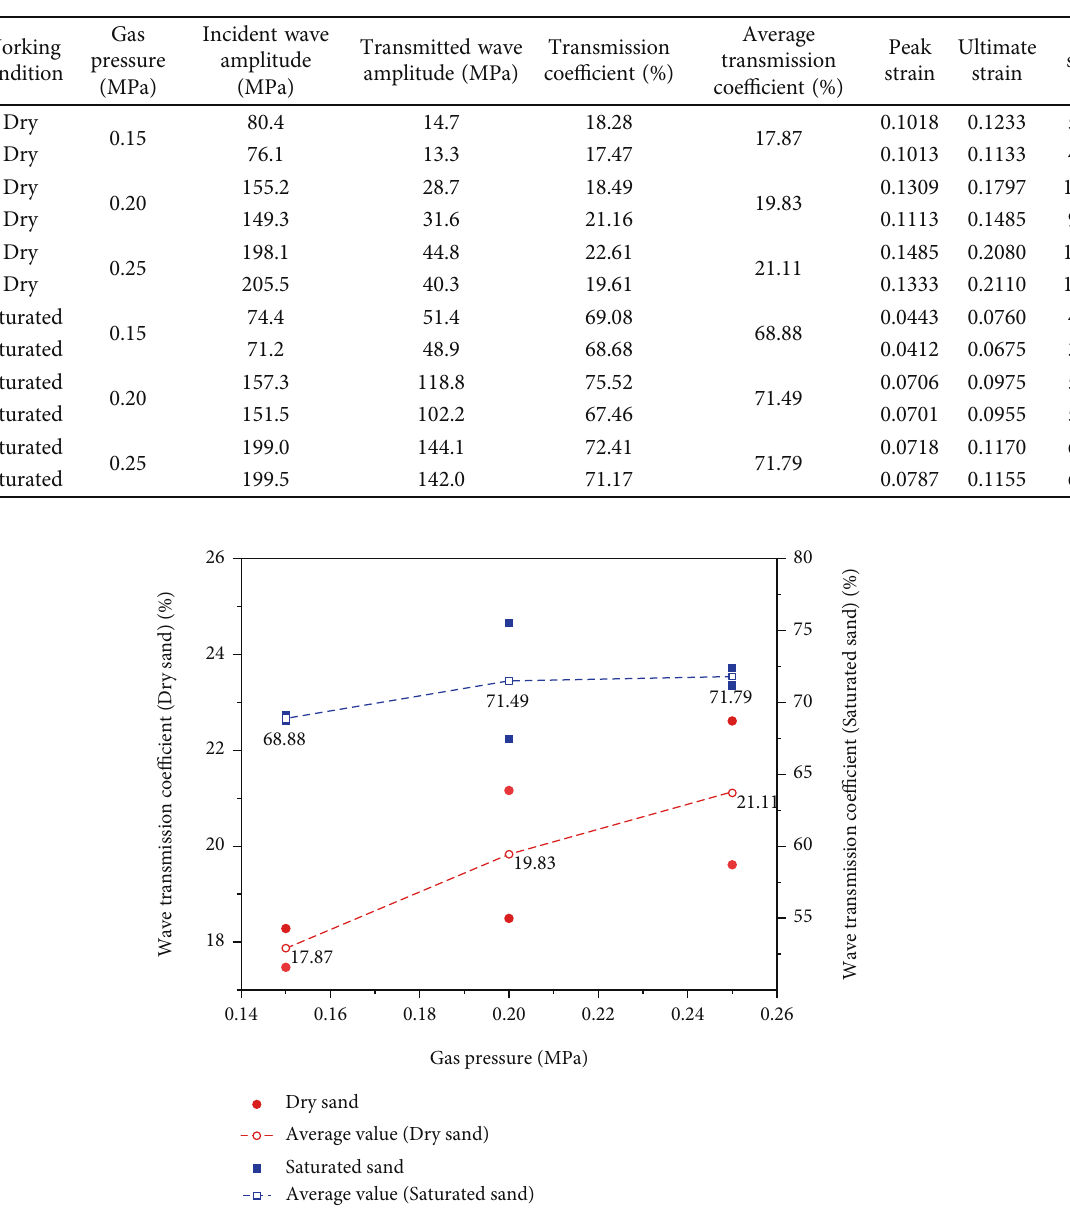
Table 1: The basic parameters and main results of the test.